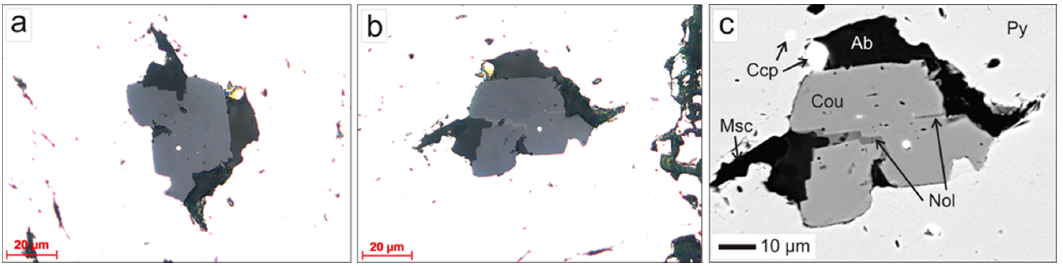
Figure 7. Coulsonite-III (Cou) crystal with nolanite (Nol) in the marginal area from massive pyrite ores: ( a )—reflected light images; ( b )—the same image rotated 90 ◦ ; ( c )—BSE images. Ab—albite, Ccp—chalcopyrite, Msc—muscovite, Py—pyrite.